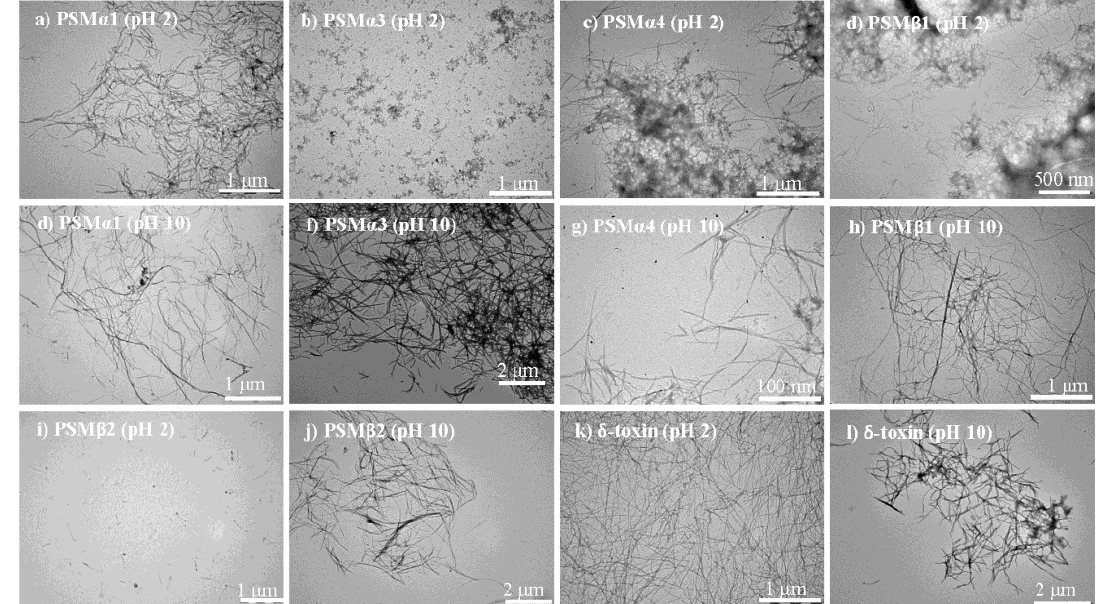
Figure 5. Morphology of aggregates of PSM peptides at one acidic (pH 2) and one basic (pH 10) condition. Transmission electron microscopic image of the end-state of reaction for samples initially composed of ( a ) PSM α 1 fibrils (pH 2), ( b ) PSM α 3 fibrils (pH 2), ( c ) PSM α 4 fibrils (pH 2), ( d ) PSM β 1 fibrils (pH 2), ( e ) PSM α 1 fibrils (pH 10), ( f ) PSM α 3 fibrils (pH 10), ( g ) PSM α 4 fibrils (pH 10), ( h ) PSM β 1 fibrils (pH 10), ( i ) PSM β 2 fibrils (pH 10), ( j ) PSM β 2 fibrils (pH 2), ( k ) δ -toxin fibrils (pH 2), and ( l ) δ -toxin fibrils (pH 10). Please note that the scale bar changes.